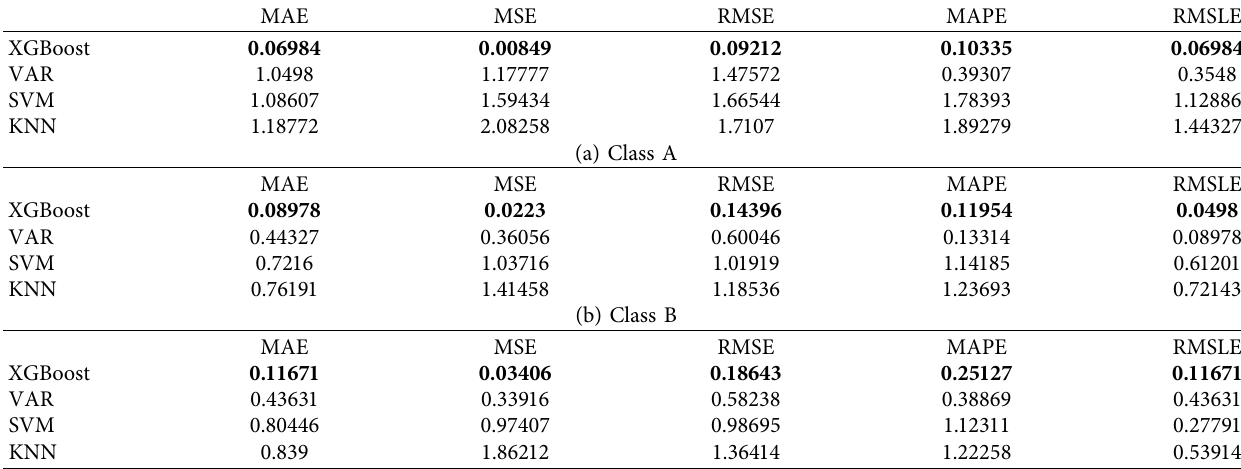
Table 12: Machine learning for combined features evaluation